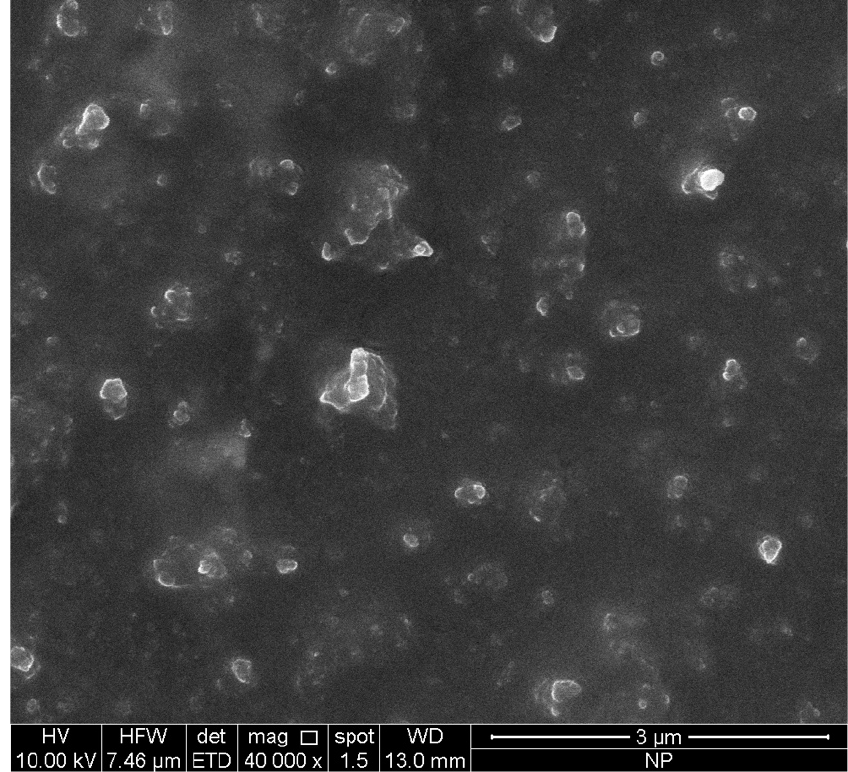
Figure 1. Scanning electron microscopy of N/OFQ-loaded SLNs.